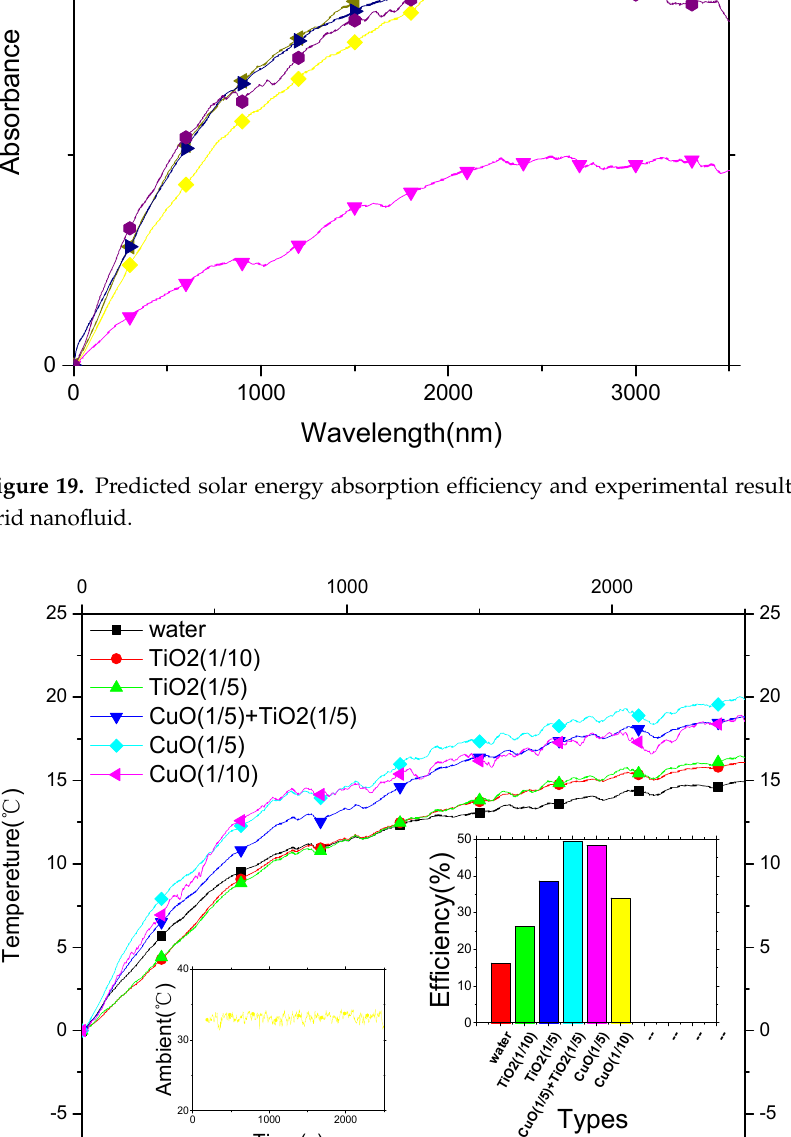
Figure 20. Experimental results of five kinds of hybrid nanofluids. 20 times diluted copper, 10 times diluted copper, mixed nanofluid of 10 ppm gold and 10 times diluted copper, 10 ppm gold nanofluid and 5 ppm gold nanofluid are calculated as 16.25%, 21.54%, 25.38%, 41.67%, 48.67%, and 40.57%, respectively. The efficiency of the mixed nanofluid of 10 ppm gold and 10 times diluted copper is lower than the absorption efficiency of 10 ppm gold nanofluid but higher than water, 20 times diluted copper, 10 times diluted copper and 5 ppm gold nanofluid.